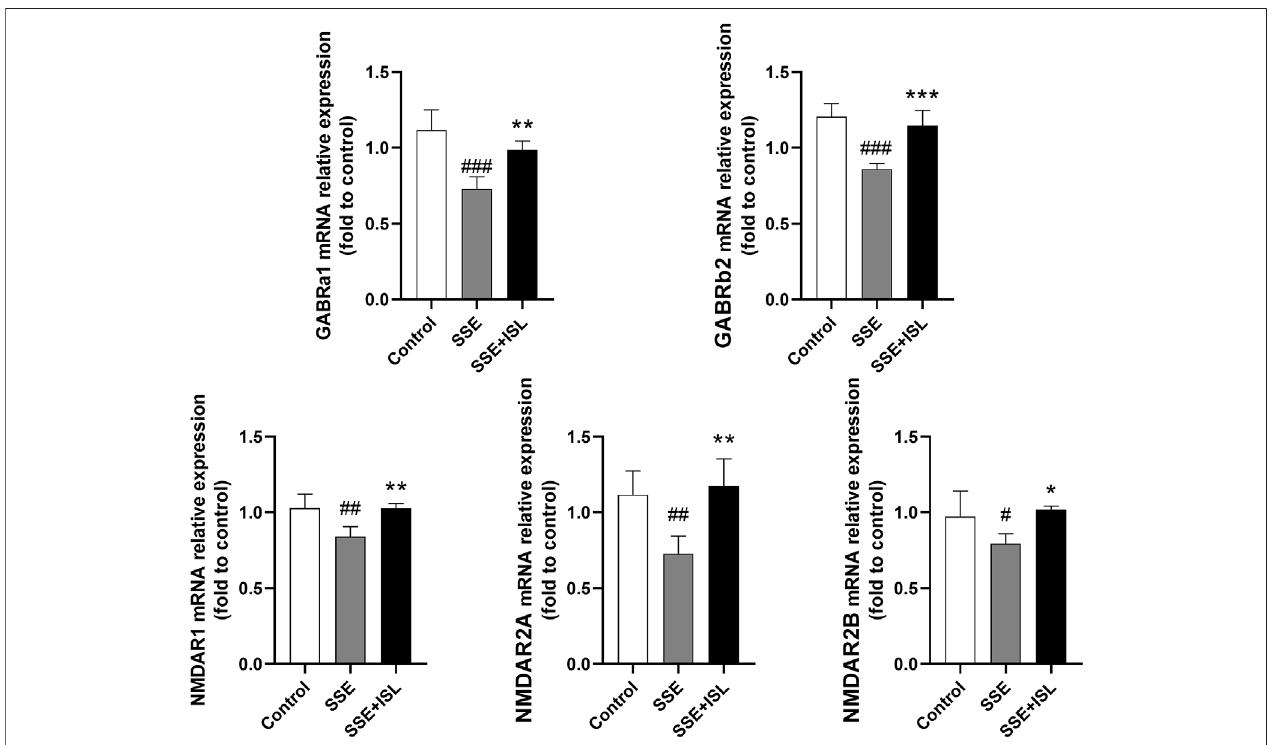
FIGURE 6 | Quantitative analysis by qRT-PCR demonstrates the mRNA levels of NMDAR1, NMDAR2A, NMDAR2B, GABRa1, GABRb2 in the hippocampal homogenates. Values are presented as mean ± SD ( n (cid:1) 4). # p < 0.05 (SSE group vs. control group), * p < 0.05 (SSE + ISL group vs. SSE group).